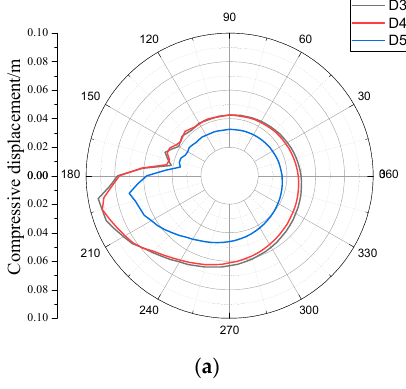
Figure 22. Distribution of soil displacement outside pile under compression and bearing load. ( a ) Displacement under compression of 0.1 m; ( b ) 9 MN compressive load.